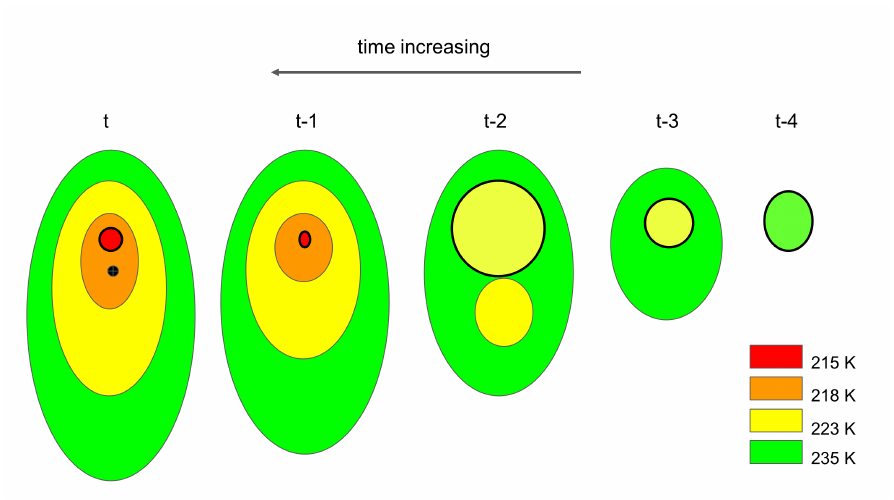
Figure 3. Simplified scheme of adaptive threshold technique. The black dot represents the ERPF centroid location and filled contours different temperature clusters. Bold lines denote the temperature threshold at each